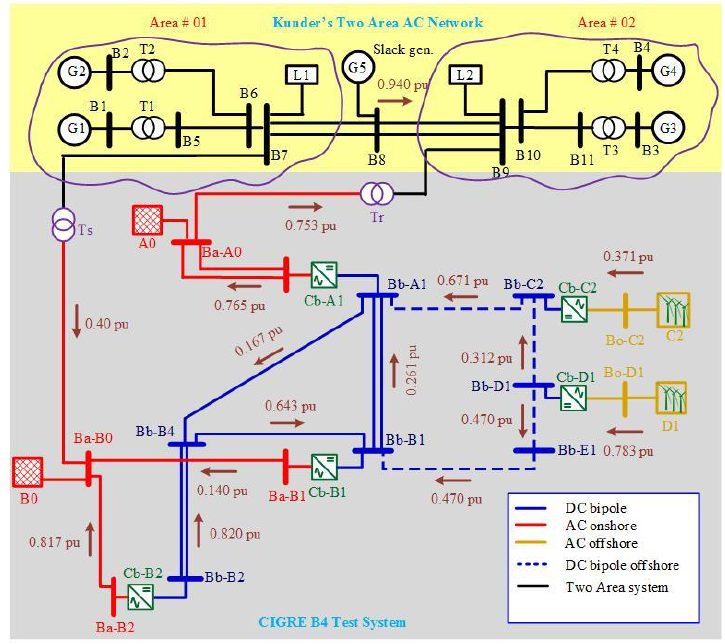
Figure 7. Interconnected AC/DC grid with slack bus.